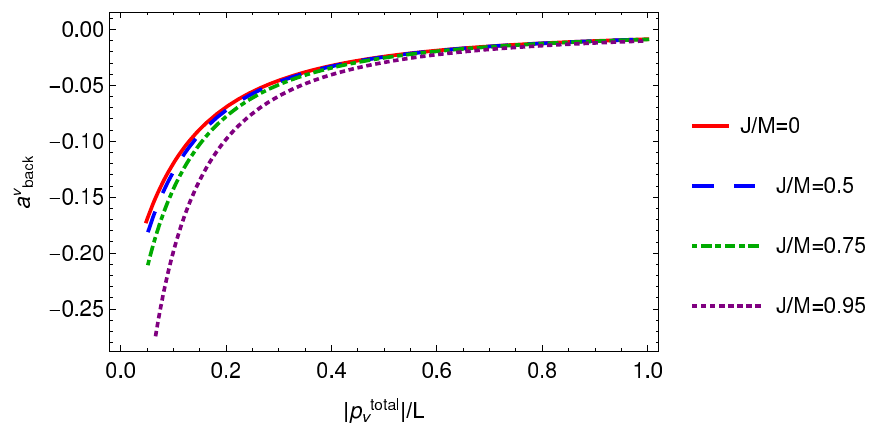
Figure 11 . Opening of the wormhole as a function of momentum p total over transverse space. Fixed temperature T = 1